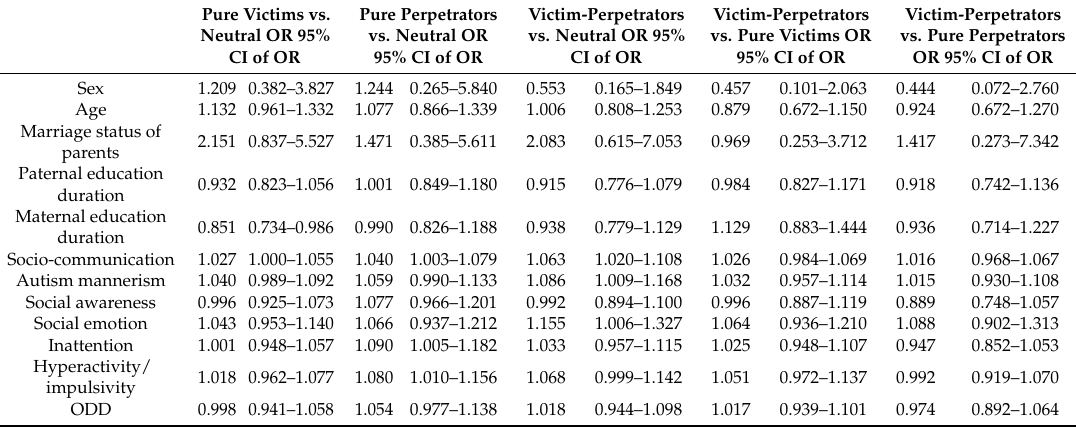
Table 3. The factors related to self-reported bullying involvement: logistic regression a .